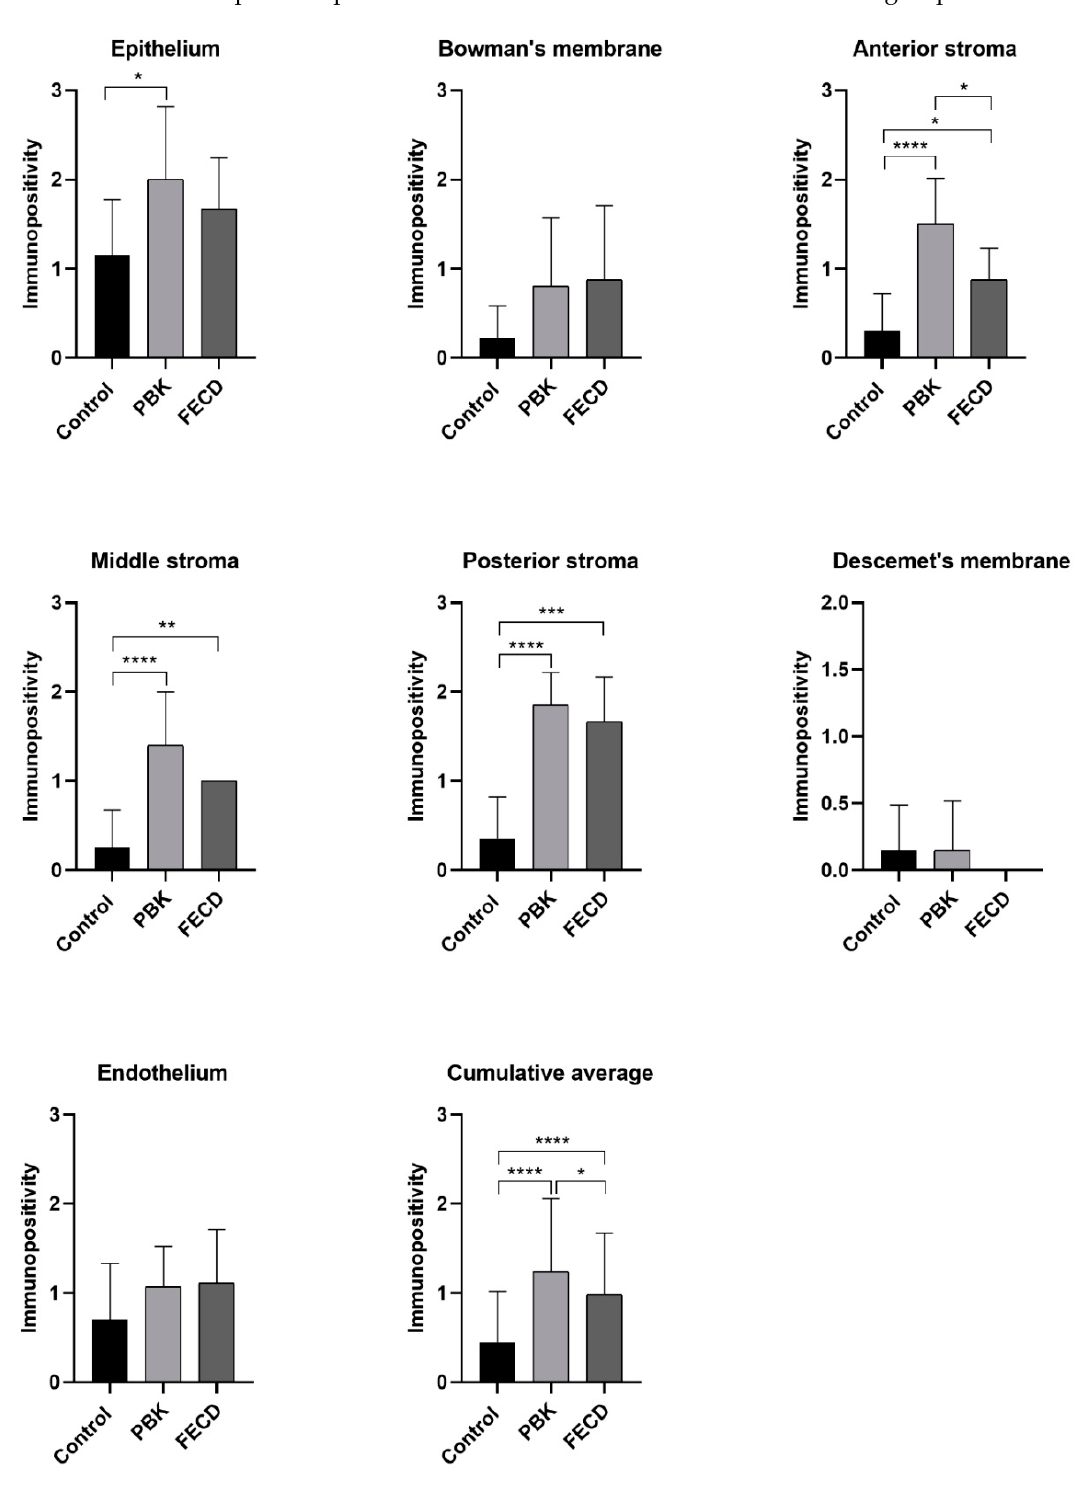
Figure 1. The average tenascin-C immunopositivity in the different corneal layers in normal and pathologic conditions. PBK = pseudophakic bullous keratopathy, FECD = Fuchs’ endothelial corneal dystrophy. Columns indicate the average immunopositivity (0 means no staining, 0.5+ minimal, 1+ mild, 2+ moderate, 3+ marked positivity). * = level of significance ( p < 0.05 *; p < 0.01 **; p < 0.001 ***; p < 0.0001